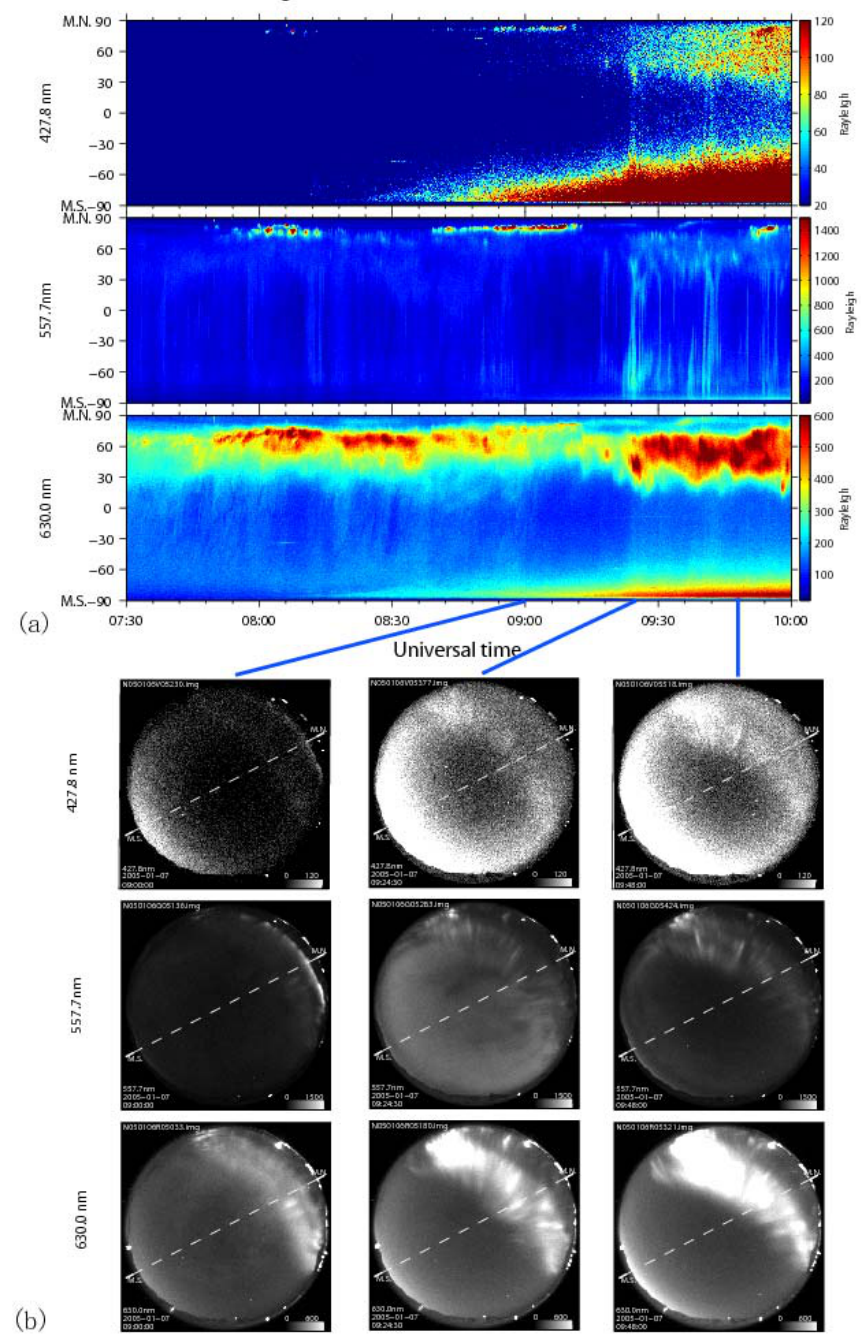
Fig. 2. (a) The YRS ASI observed keograms of the temporal variation of three-wavelength emission intensities along the magnetic meridian for three wavelengths at 427.8nm, 557.7nm and 630.0nm respectively, for the time interval of 07:30–10:00UT on 7 January 2005. The ver- tical axis gives the zenith angle (ZA) on the magnetic meridian (M.S. denotes magnetic south, and M.N. magnetic north), and the horizontal axis shows the universal time (UT). (b) The snap-shots of the YRS all-sky images of dayside aurora for the three wavelengths at 427.8nm, 557.7nm, and 630.0nm at three specific time stamps, 09:00:00UT, 09:24:30UT, and 09:48:00UT. The magnetic meridian is given by the dashed line in each panel. The rather uniform intensification in the southern horizon at the time interval after ∼ 08:30UT is probably the dawn